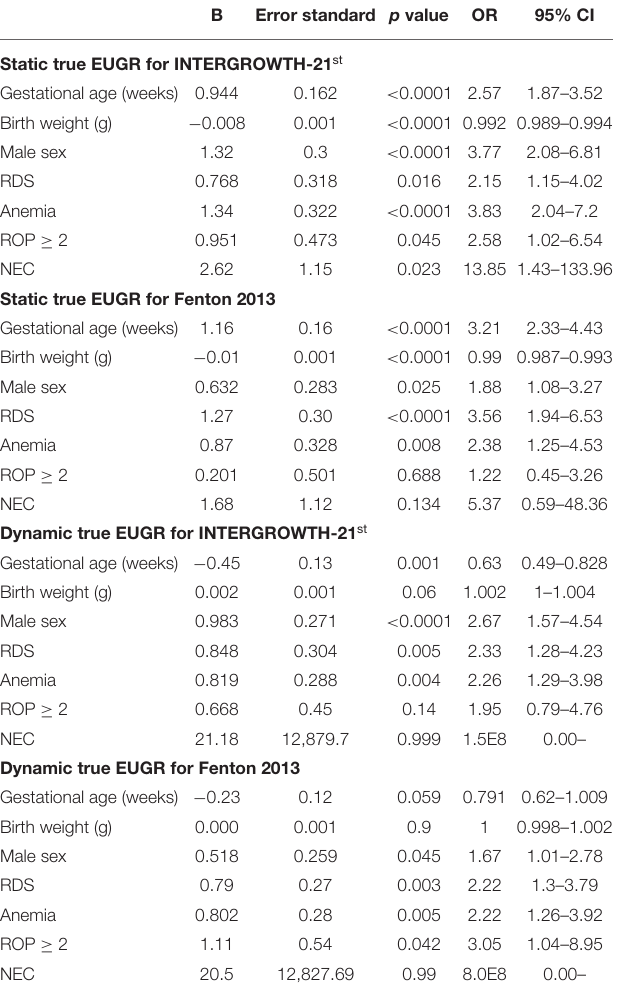
EUGR prevalence of 42.7% by IW-21, and higher than those of Tuzun et al. (17), who published 24 and 37.7% for IW-21 and Fenton,